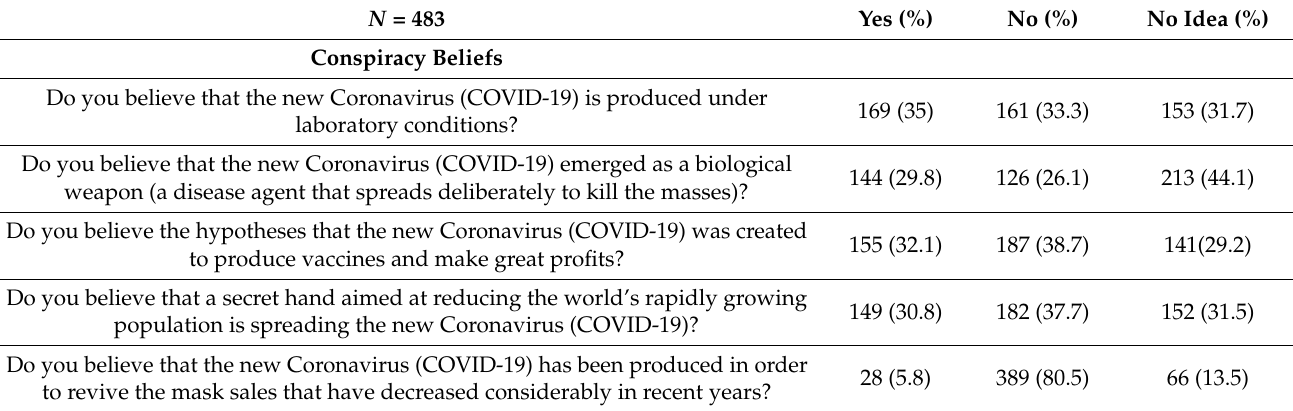
Table 3. The COVID-19 perceptions and conspiracy beliefs of the